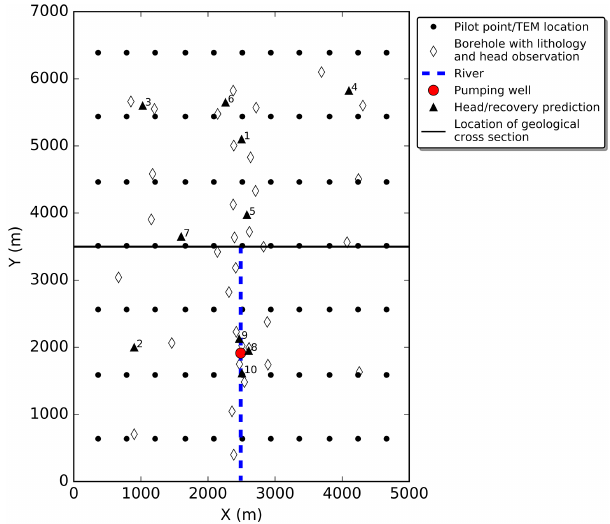
Figure 2. A map of locations of boreholes, a pumping well, geo- physical data, pilot points, predictions of interest and location of a geological cross section. (The positions of the pilot points and geo- physical measurements are